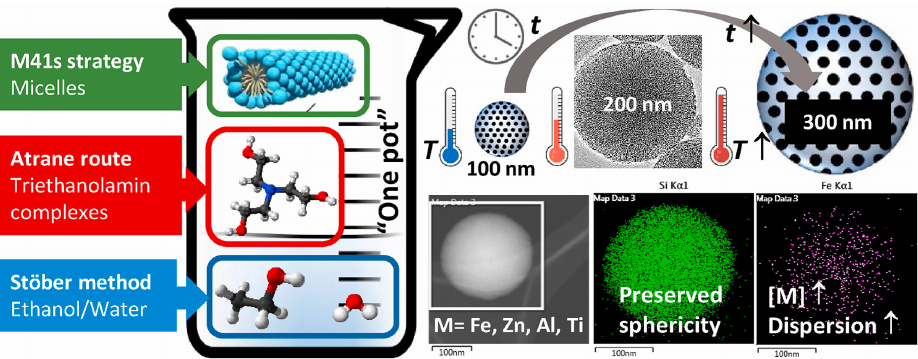
Figure 3. One-pot preparative strategy and representative micrographs of the mesoporous silica functionalized with homogeneous distributed elements (Fe, Zn, Al, or Ti). Reproduced with permission from Ref. [77], Copyright 2022, Elsevier.